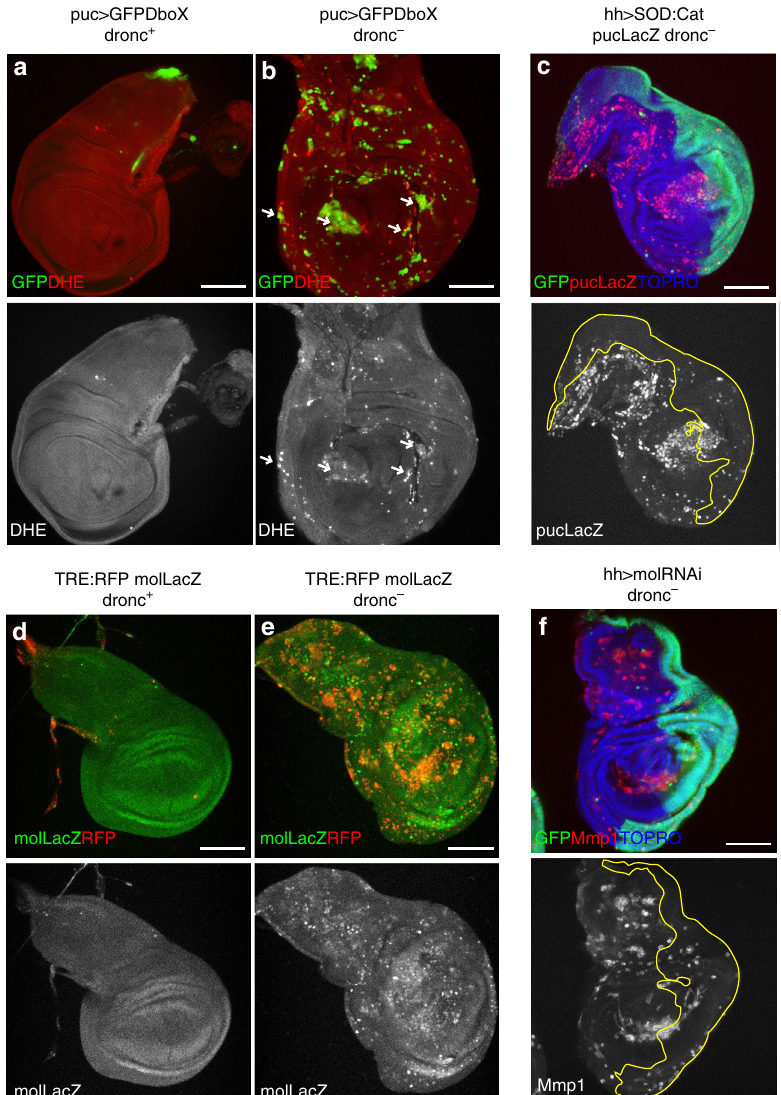
Fig. 2 ROS and moladietz are involved in JNK persistent activity. a , b Wing discs stained 96 h after irradiation with DHE to detect ROS, a dronc + control ( n = 10) and b dronc − mutant ( n = 30). We observe DHE staining in dronc − mutant disc ( b , arrows) in cells that present JNK activity, labelled by the expression of UAS-GFPDbox , but not in ( a ) dronc + control. c Wing disc of the genotype: UAS-SOD:UAS-Cat/UAS-GFPtubGal80 ts ;dronc i24 /dronc i29 hh-Gal4 96 h after irradiation ( n = 14) (after irradiation, larvae were raised for 24 h at 17 °C to allow ROS activation and then transferred to 29 °C for 72 h to block ROS production). We observe a reduction in the activation of JNK ( puc-LacZ , red) only in the posterior compartment (GFP, green), where SOD : Cat are expressed. Wing discs of the genotypes: d ( n = 9) TRE:RFP/mol-LacZ and e ( n = 22) TRE:RFP/mol-LacZ;dronc i24 /dronc i24 96 h after irradiation where mol- LacZ expression (green) is maintained in dronc − mutants ( e ) in cells that show JNK activity ( TRE:RFP , red). No RFP or ectopic mol-LacZ is observed in ( d ) dronc + control. f Wing disc of the genotype: UAS-molRNAi/UAS-GFPtubGal80 ts ;dronc i24 /hh-Gal4dronc i29 ( n = 7) 96 h after irradiation. As in c , the mol RNAi was expressed the last 72 h after irradiation. Reduction of the JNK activity (Mmp1, red) is observed in the posterior compartment (green), but not in the anterior. Scale bars are 100 μ